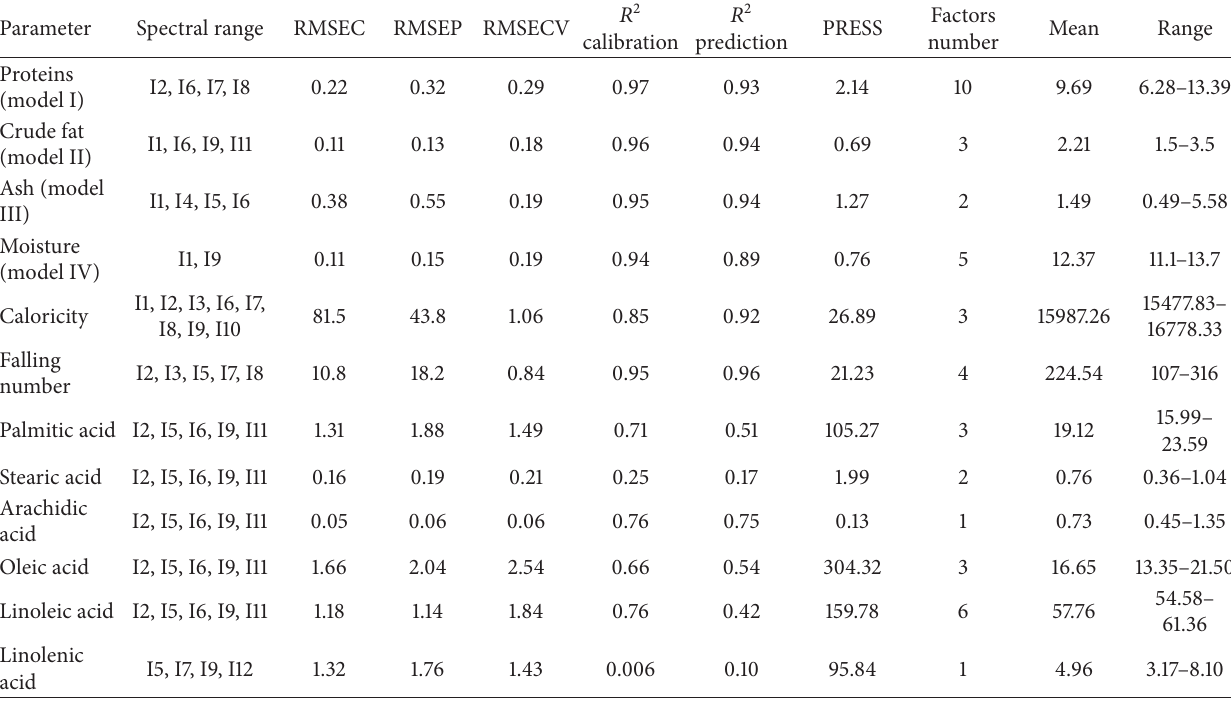
Table 6: Parameters describing the calibrated models obtained with